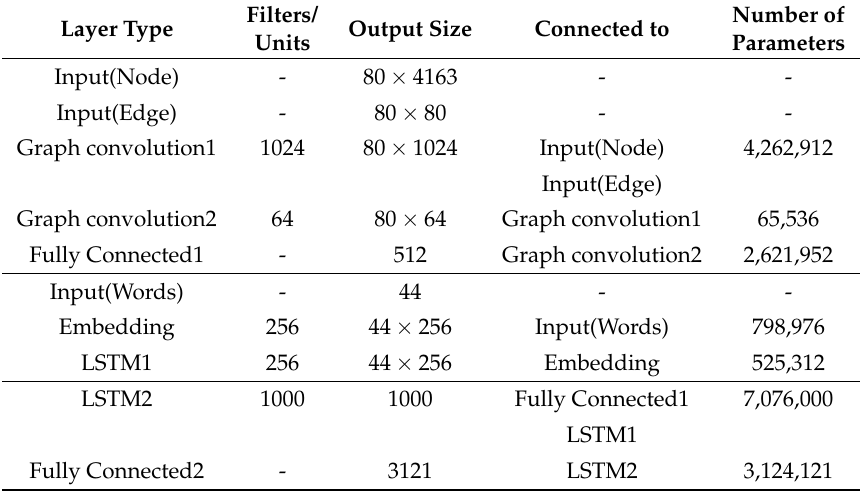
Table A1. Overall neural network architecture for language